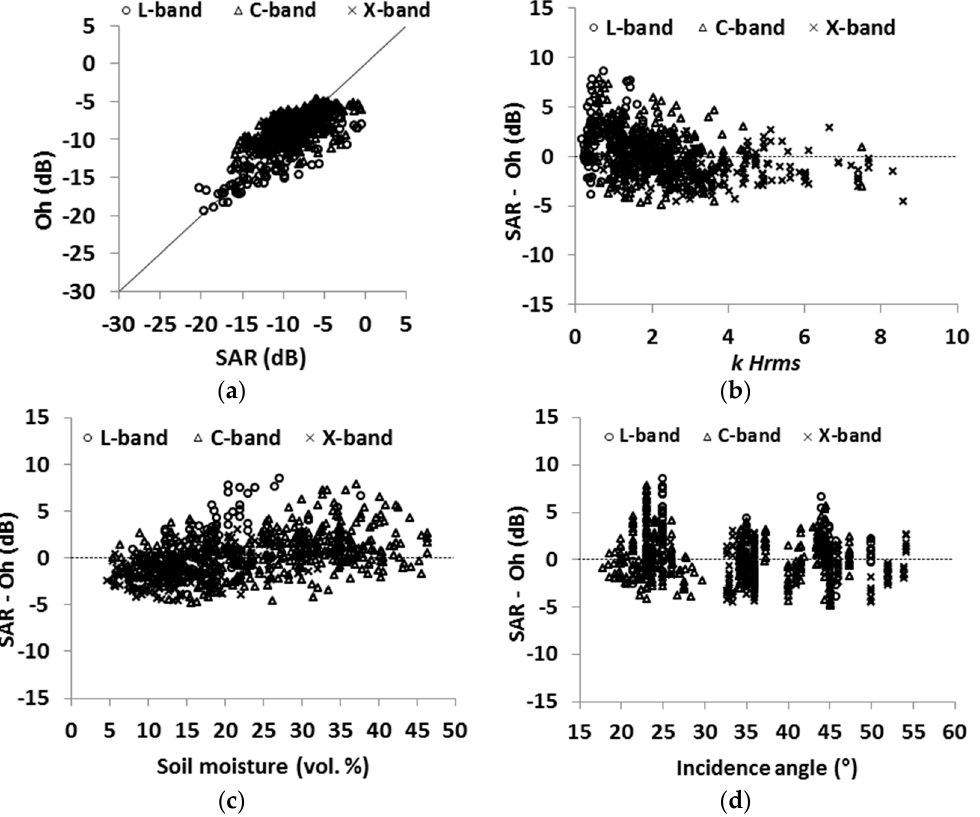
Figure 4. Comparison between backscattering coefficients derived from SAR images and those estimated from the Oh 1992 model at VV polarization, ( a ) Oh simulations vs. SAR data; ( b ) difference between SAR signal and the Oh model vs. soil roughness ( kHrms ); ( c ) difference between SAR signal and Oh model results vs. soil moisture ( mv ); ( d ) difference between SAR signal and Oh model results vs. incidence angle.